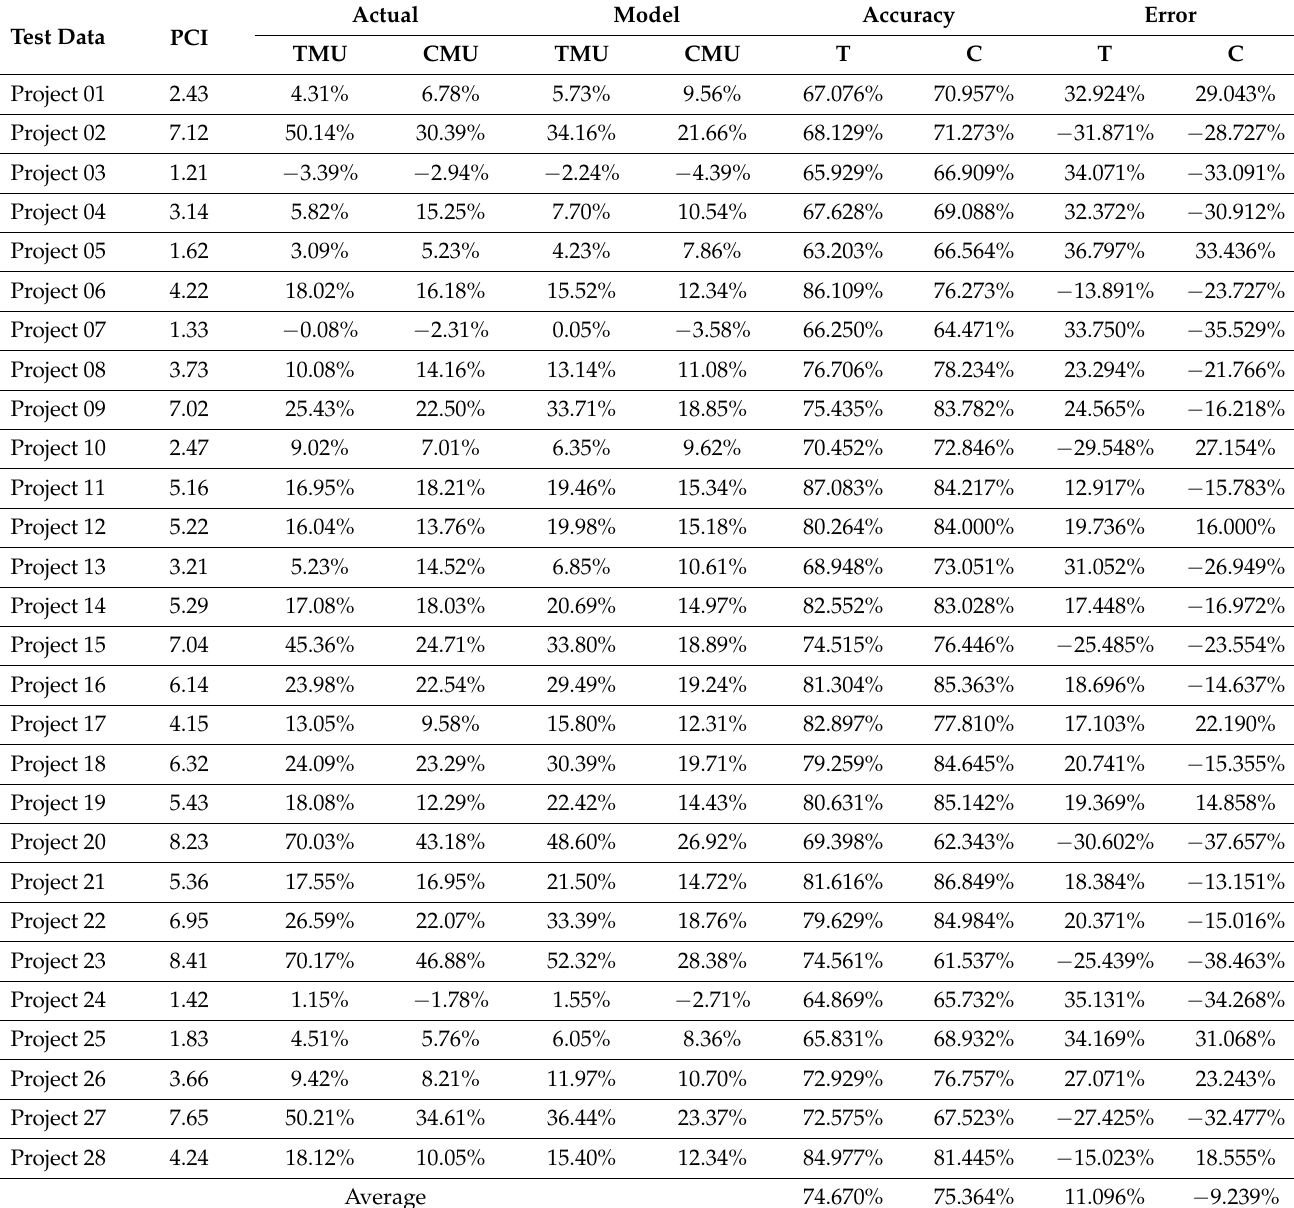
Figure 7. Correlation between the PCI and the percentage of the results’ accuracy time mark-up ( left ) and cost mark-up ( right ). Table 9. Accuracy of the outputs of the proposed model versus the actual data.